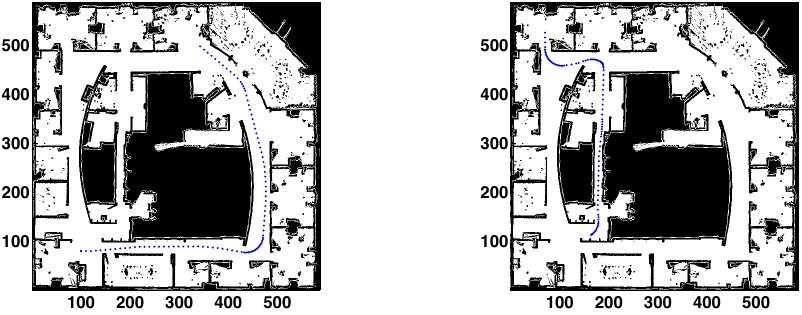
Figure 5. ( Left ) Path 1. Starting point: bottom left corner; ( Right ) Path 2. Starting point: upper left corner.